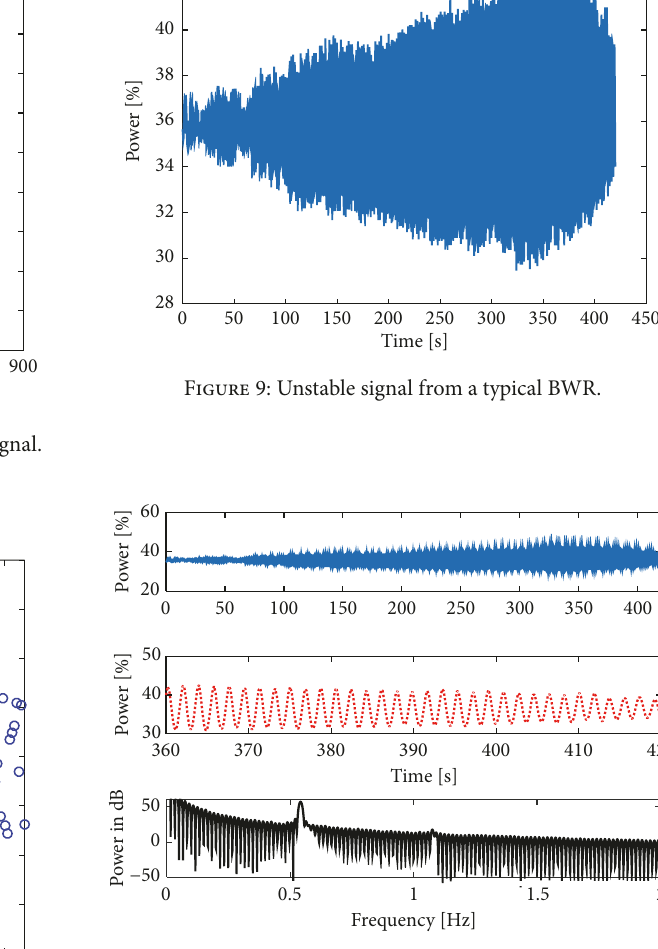
Figure 10: Analyzed segment of the studied LPRM 2 signal.